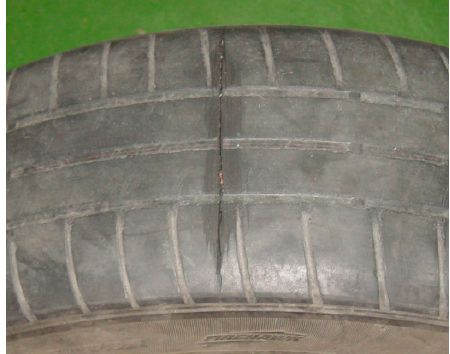
Figure 22. Tire damaged—transverse cut.